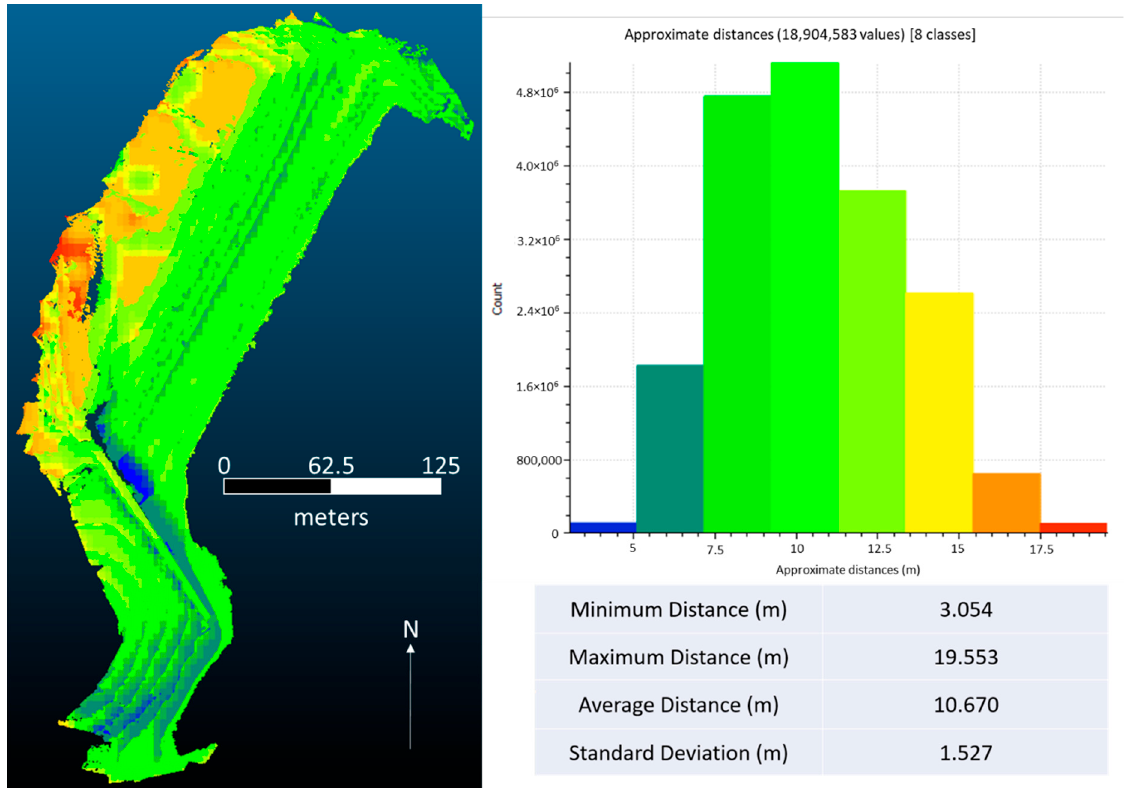
Figure 10. Difference between reference model and point cloud generated without GCPs. These are Euclidian distances measured in three dimensions, not just the horizontal distance.